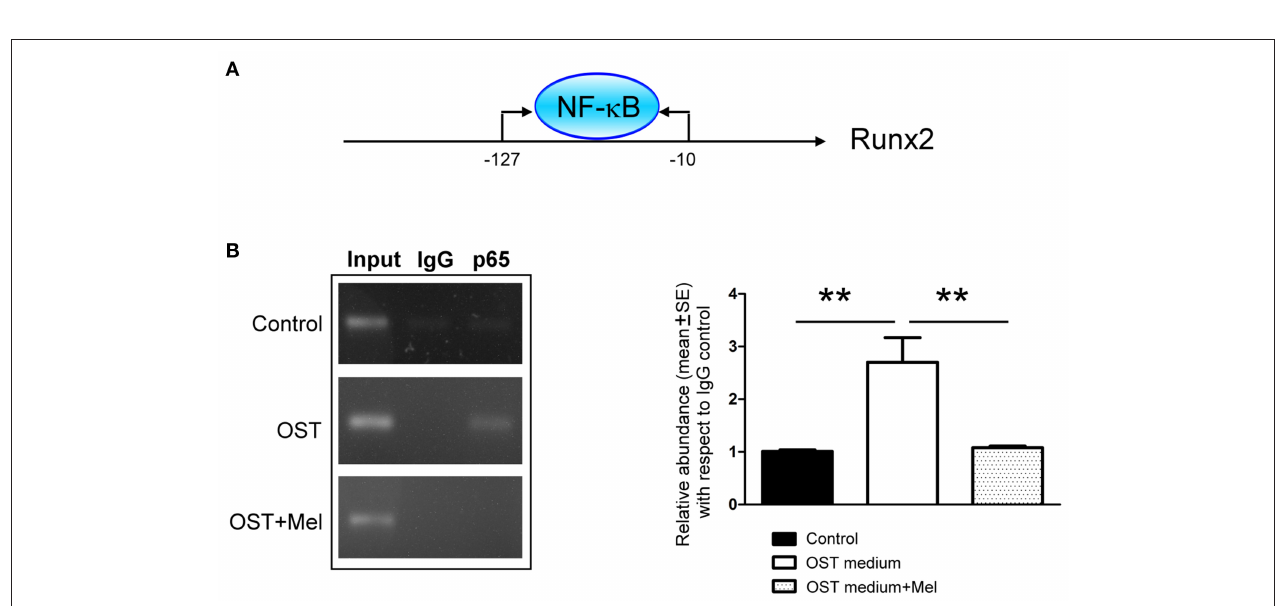
FIGURE 6 | NF- κ B-binding activity on the promoter region of Runx2 was determined by a ChIP assay (A) Schematic of the PCR amplification site of Runx2 promoter regions (B) Representative PCR products and summary data after ChIP assay ( n = 4). We retained 1% of total DNA as the input control DNA. Data are presented as mean ± SEM. OST, osteogenic medium; Mel, melatonin. ** P < 0.01.